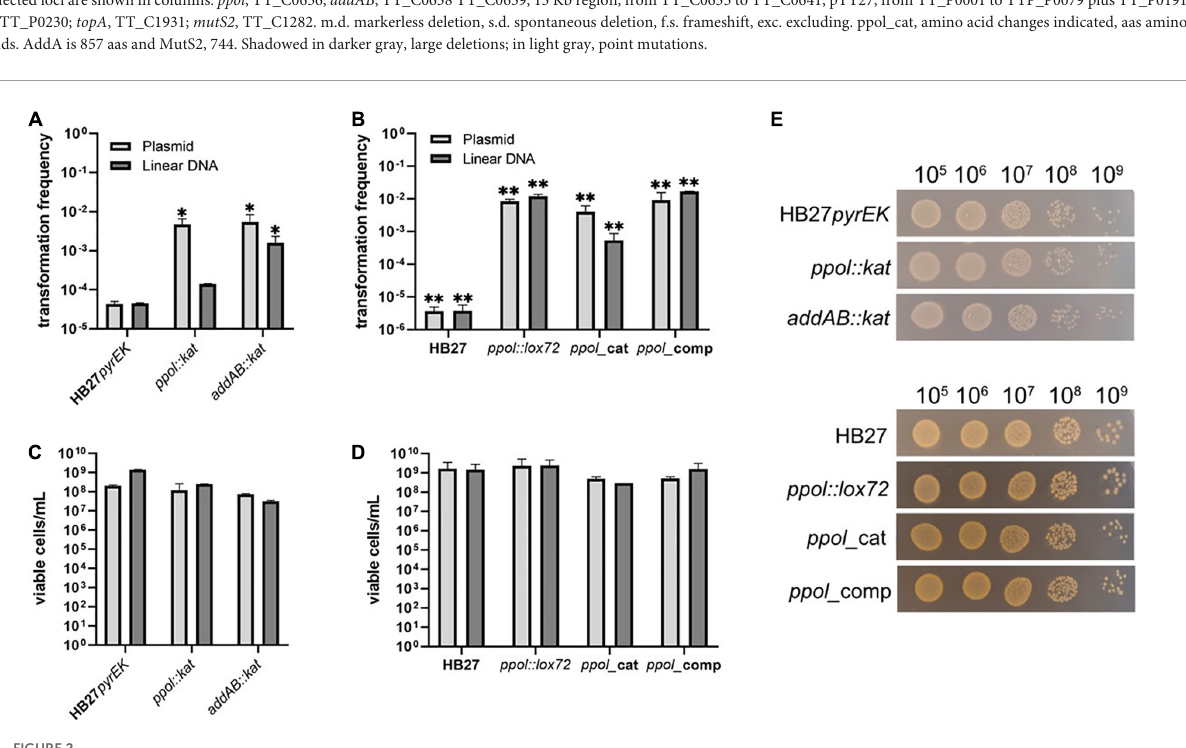
FIGURE2 Transformation efficiency of Thermus thermophilus mutants. (A) Hundred nanogram of a replicative plasmid (pMotH1103A) or an homologous-recombination integrative linear DNA fragment conferring resistance to Hyg (pyrEH), were used to transform Tth HB27 pyrEK control strain and ppol:kat and addAB:kat insertion mutant. (B) Hundred nanogram of a replicative plasmid (pMotK1103A) or an homologous-recombination integrative linear DNA fragment (pyrEK) conferring resistance to Kn, were used to transform Tth HB27 cells and its derivatives ppol:lox72, ppol_ cat , ppol_ comp, addAB:lox72 , and addAB_ppol mutants. (C) Viable cells per mL of the kat -marked transformed strains in Kn plates. (D) Viable cells per mL of the markerless transformed strains in TB plates. (E) Serial dilutions of transformed cells of the indicated strains plated on Kn (upper panel) or non-selective plates (lower panel) and incubated for 48 h at 65 ◦ C. Transformation is represented as the number of colonies on selection plates at 65 ◦ C, relative to the number of viable colonies on non-selective plates. Transformation frequencies were calculated as an average of at least five biological replicates. Error bars correspond to the standard deviation of the means. Asterisks indicate statistically different values observed in mutant strains compared to those in the corresponding control strains (* P -value < 0.005 and ** P -value <